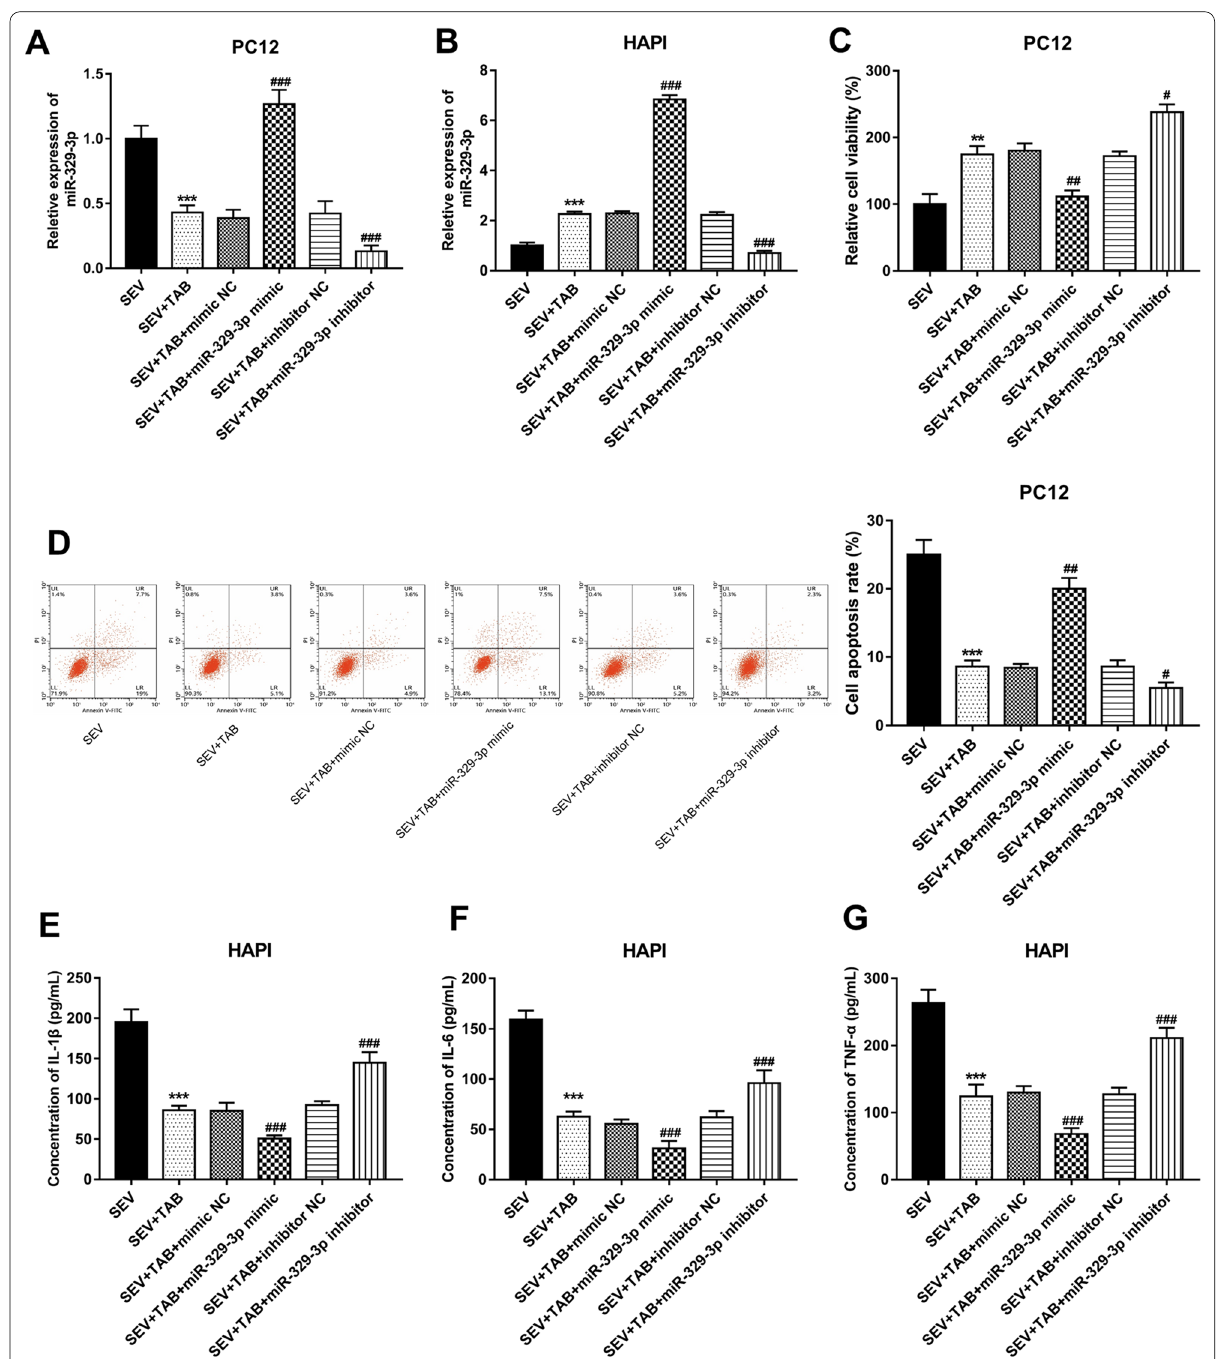
Fig. 5 miR-329-3p mediated the effects of TAB on PC12 cellviability and HAPI inflammation. A , B miR-329-3p was significantly upregulatedby the miR-329-3p mimic, but was downregulated by the miR-329-3p inhibitor. C , D The effects of TAB on PC12 cell viability and apoptosis were reversed bymiR-329-3p overexpression, but were enhanced by miR-329-3p inhibition. E – G Thereduced IL-1β ( E ), IL-6 ( F ) and TNF-α G induced by TAB were further inhibitedby miR-329-3p overexpression, but was elevated by the knockdown of miR-329-3p.** P < 0.01, *** P < 0.001 compared to SEV; # P <0.05, ## P <0.01, ### P < 0.001 compared to SEV +